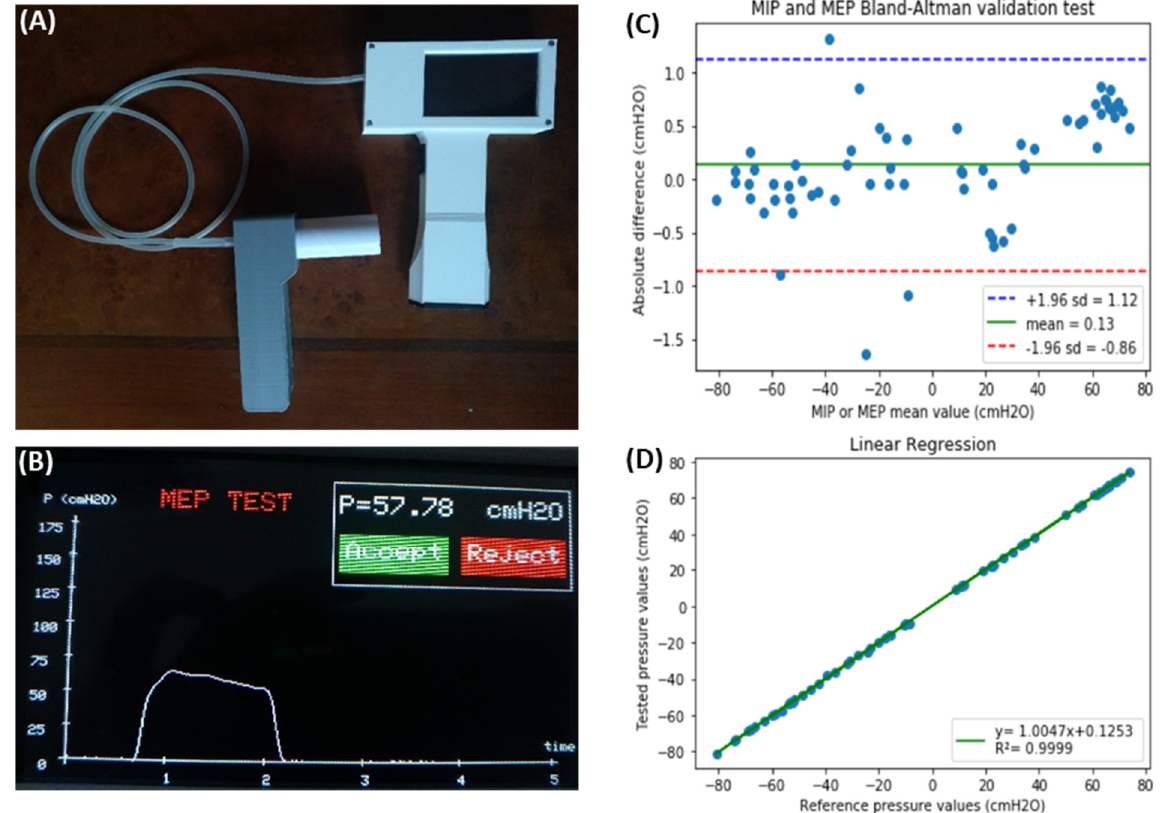
Figure 1. ( A ) Complete external view of the device showing the operator’s handheld block and the patient’s mouthpiece block, connected through a flexible silicone tube. ( B ) Example of one of the screens during device operation, showing the result of an MEP maneuver test (time course of expiratory pressure, MEP result, and the option to allow the user to accept or reject this specific maneuver). ( C ) Bland–Altman plot showing the difference between values measured by the prototype and by laboratory reference equipment, as a function of the measured values for both MIP (negative values) and MEP (positive values). The green line is the prototype bias, and the blue–red lines indicate the limits of agreement. ( D ) Linear regression of the values obtained with the developed device and the laboratory reference. Reprinted with permission from Ref. [59]. Creative Commons CC-BY